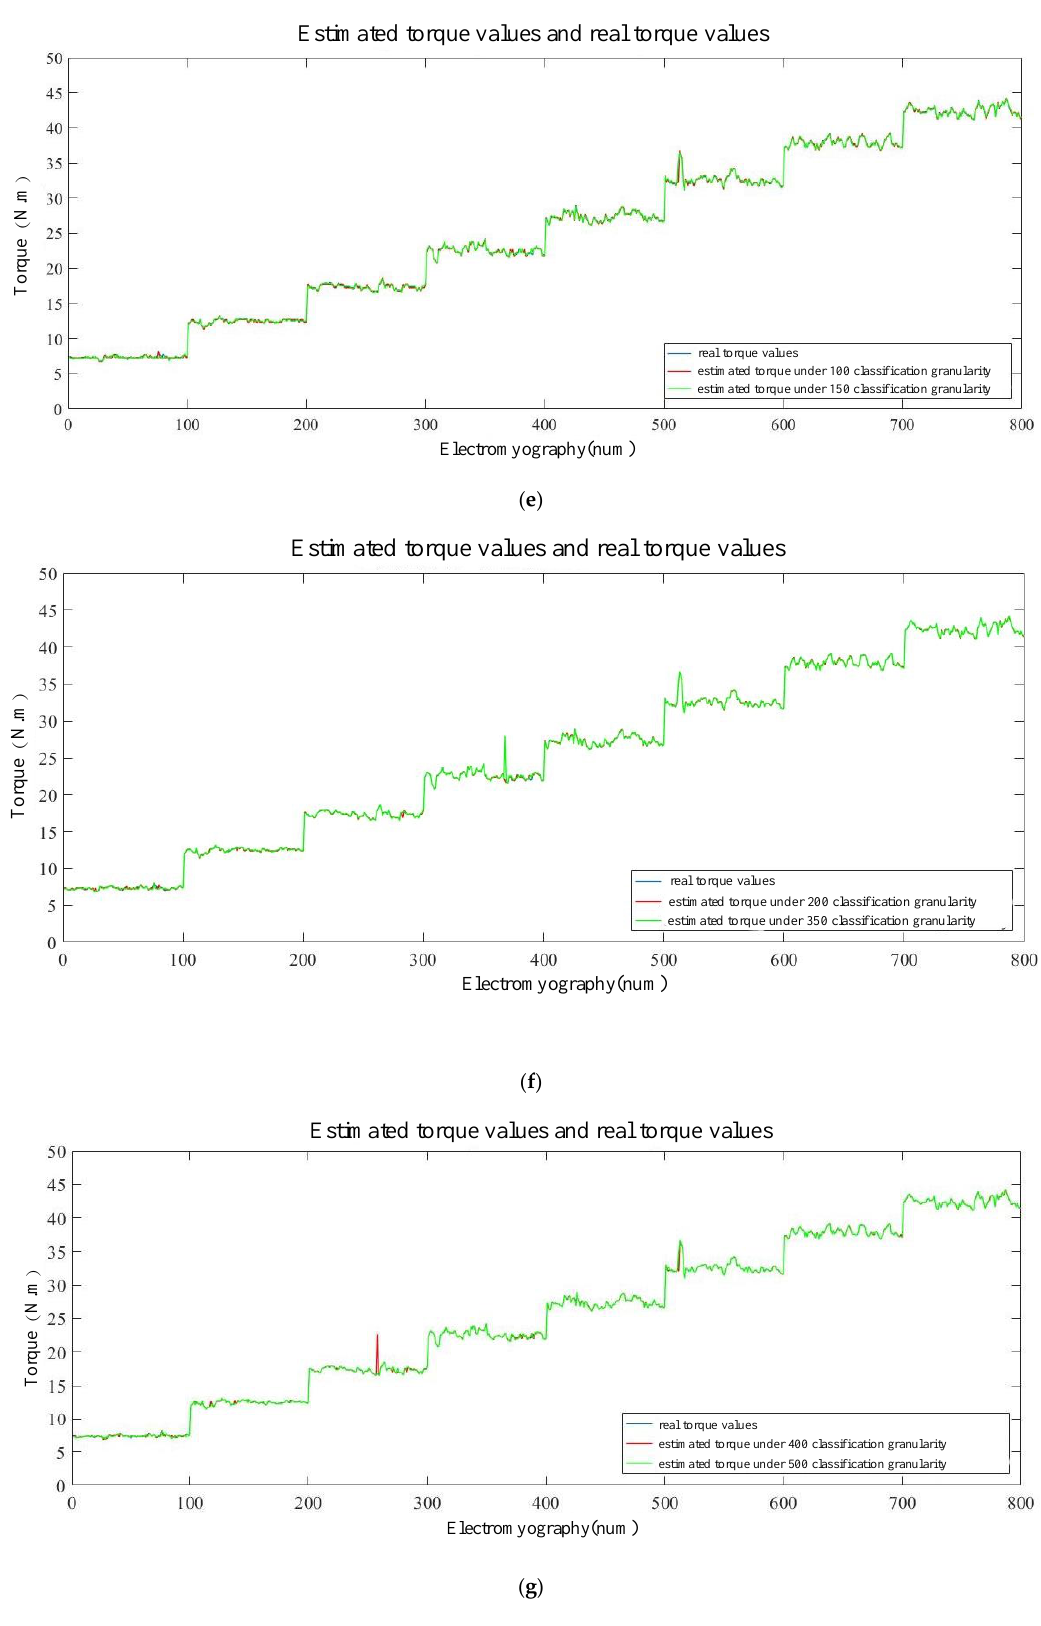
Figure 10. Estimated torque values and real torque values under different granularities: ( a ) 5, 10, and 11; ( b ) 15 and 20; ( c ) 25 and 30; ( d ) 50 and 75; ( e ) 100 and 150; ( f ) 200 and 350; ( g ) 400 and 500.